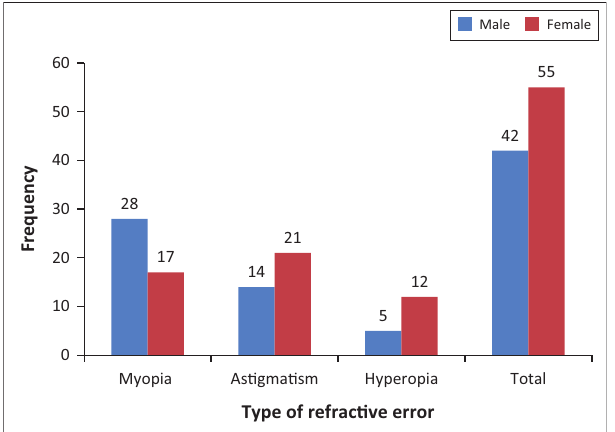
FIGURE 2: Distribution of refractive error by